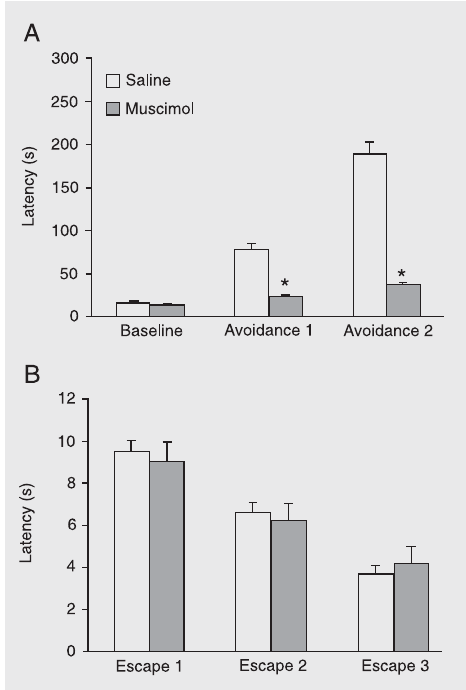
Figure 1. Effect of intra-basolat- eral nucleus of the amygdala in- jection of muscimol or saline on inhibitory avoidance (A) and es- cape (B) latencies measured in the elevated T-maze. Twenty- four hours before the test, all ani- mals were exposed to one of the open arms for 30 min. The ani- mals received 8 nmol/0.2 µL of the drug. Data are reported as means ± SEM for N = 9-10 ani- mals. *P < 0.01 compared with the saline group in the same trial (unpaired Student t